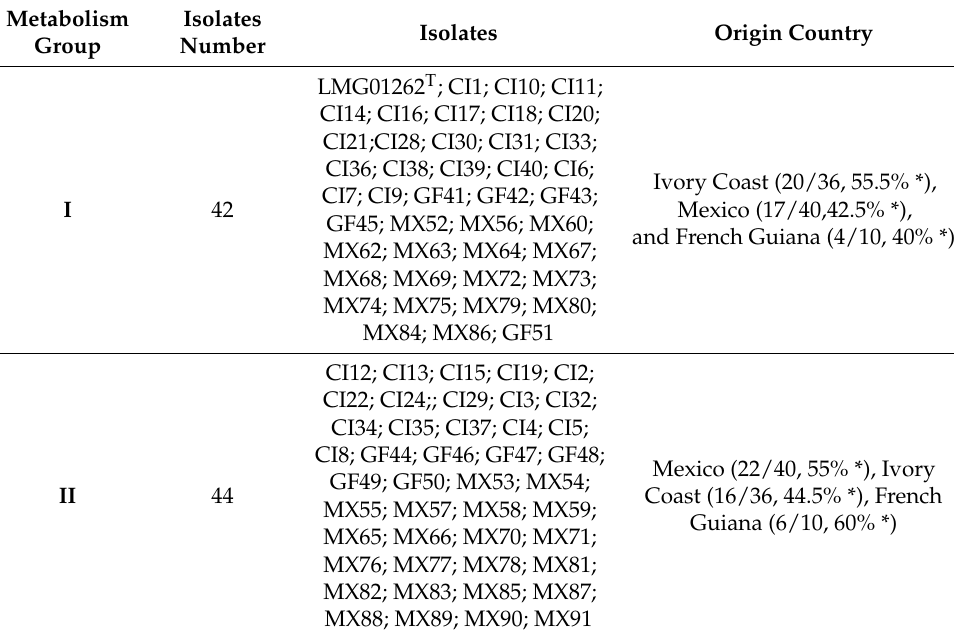
Table 3. Clustering of the A. pasteurianus strains according to their physiological